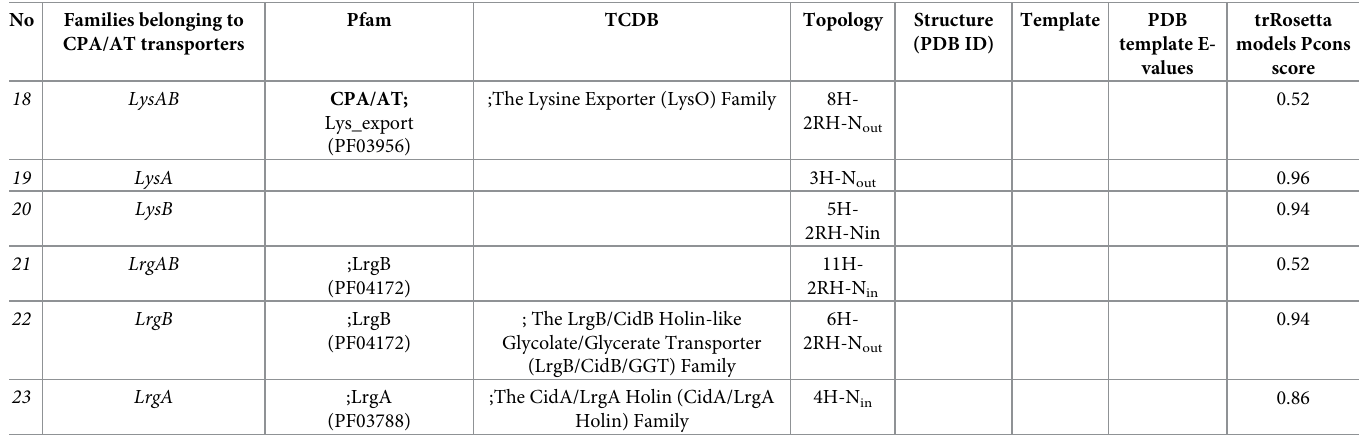
CPA-reentrant or Reentrant-helix-reentrant (RHR). Crystal structures are available for at least one family in three out of four fold-types but not for the RHR fold-type. The identification and the evolution of this new fold type are discussed in detail in the following section. All the data generated from this work is made available as “CPAfold database” (http:// cpafold.bioinfo.se). The CPAfold database can be useful to experimentalists interested in studying the structure, function, mutation and design of any protein belonging to this fold. 3D structure models are available for all the families in this fold. Functional and mutational stud- ies can be supported by these models. Reentrant motifs for the reentrant type transporters have been identified. Full length and repeat level topology and sequence alignments of a partic- the comparison of the structure and function of related families of interest.